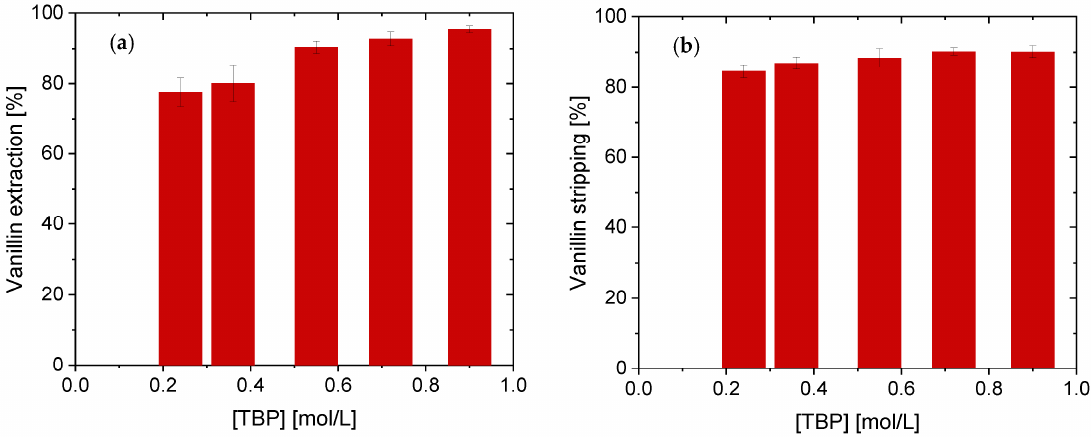
Figure 4. Effect of tri-n-butyl-phosphat (TBP) concentration on the vanillin extraction ( a ) vanillin stripping ( b